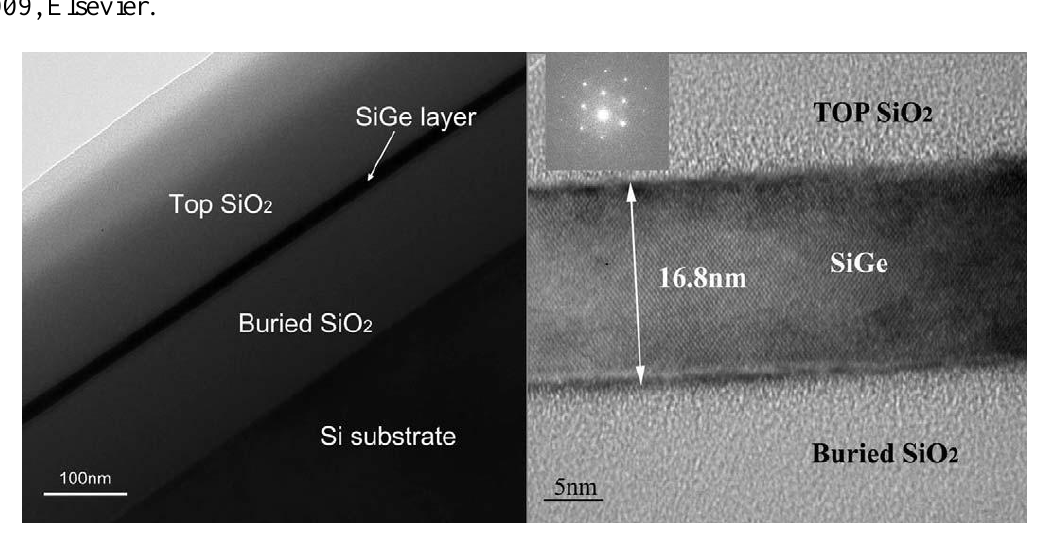
Figure 5. HRTEM images of Ge-rich SiGe layer produced by the Ge condensation technique. The Ge composition is 89%, reprinted with permission from [65]. Copyright 2009,